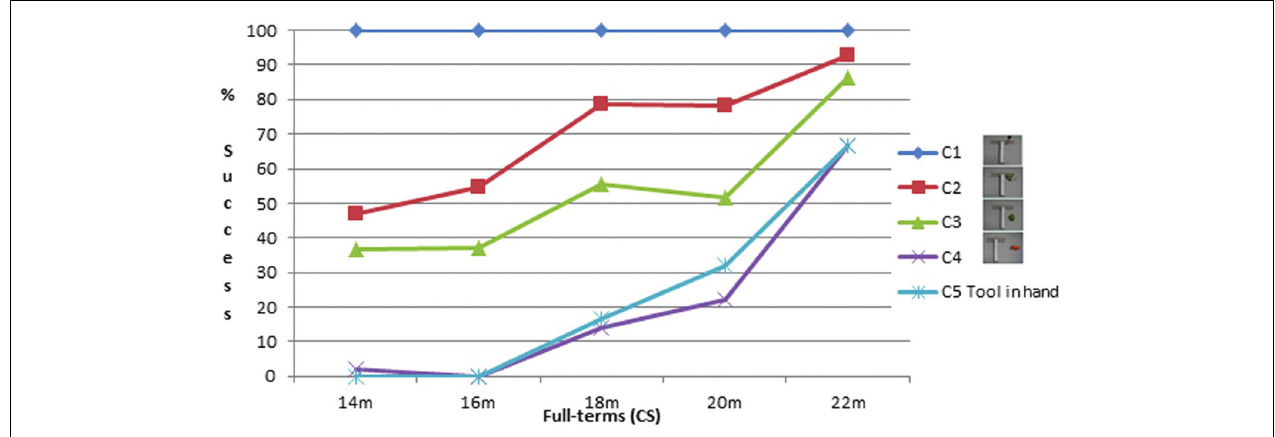
FIGURE 3 | Percentage of successful infants